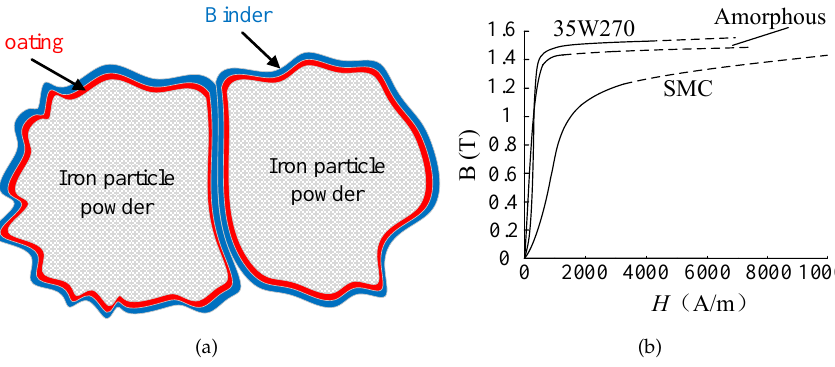
Figure 8. Material properties: ( a ) The basic components of soft magnetic composite [76]; ( b ) Magneti- zation curves of amorphous alloys, soft magnetic composite and silicon steel sheets [77,78].